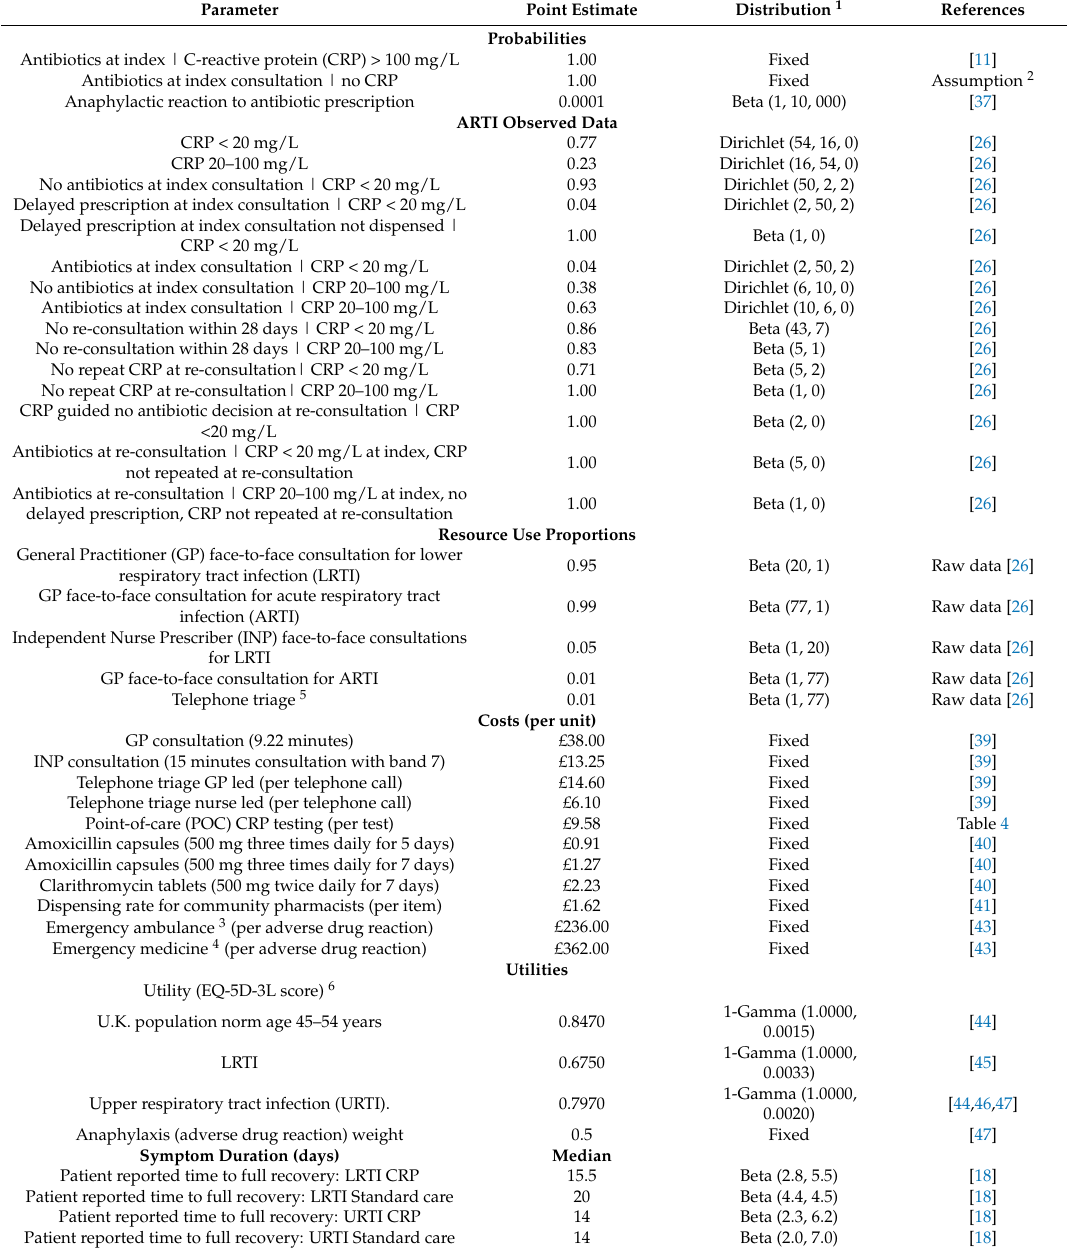
Table 3. Model input parameters: probabilities, costs and